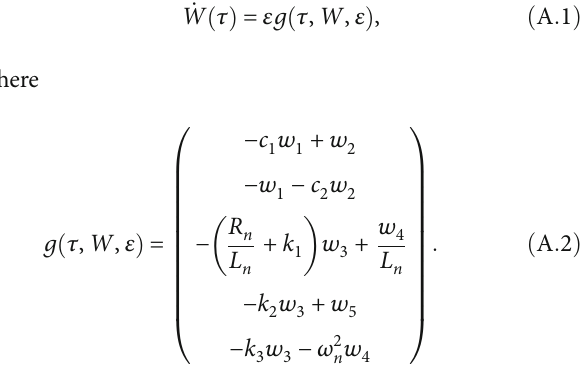
Figure 17: Voltage v